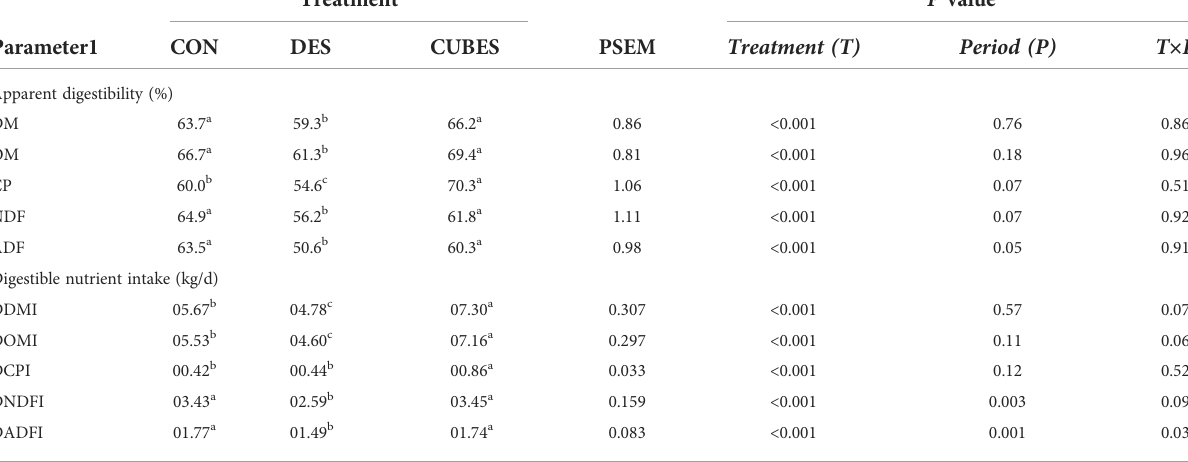
DM, dry matter; OM, organic matter; CP, crude protein; NDF, neutral detergent fi ber; ADF, acid detergent; DDMI, digestible dry matter intake; DOMI, digestible organic matter intake; DCPI, digestible crude protein intake; DNDFI, digestible neutral detergent fi ber intake; DADFI, digestible acid detergent fi ber intake; PSEM, pooled standard error of mean. a,b,c Within a row, least square means without a common superscript differ (P <